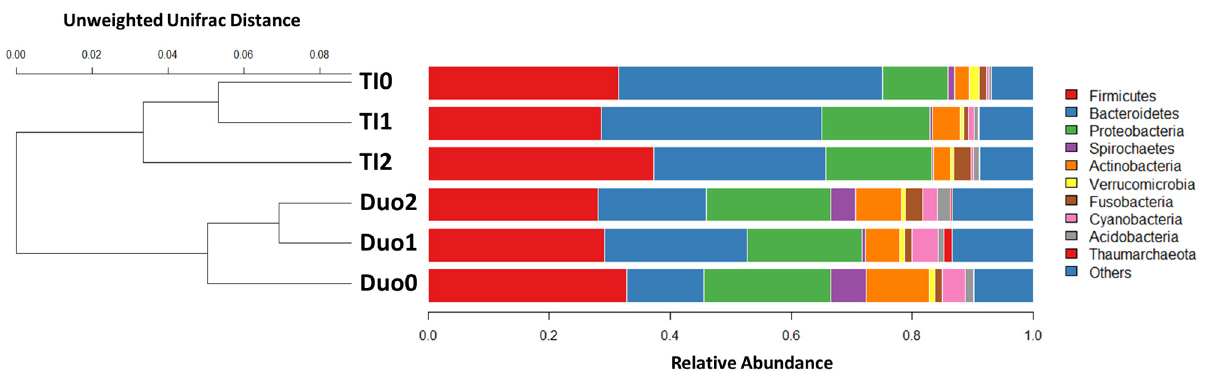
Figure 2. Unweighted Pair-group Method with Arithmetic Mean (UPGMA) analysis to assess and compare alpha and beta diversity across tissues and study groups. The bar chart depicts the relative abundance of bacteria at the phyla level for both the duodenum (Duo) and terminal ileum (TI). The dendrogram on the left allows comparison across tissues and study groups, highlighting the largest degree of difference between Duo and TI, Duo0 & TI0-Controls, Duo1 & TI1-Active CD at that biopsy site, and Duo2 & TI2-CD without active inflammation at that biopsy site, but present elsewhere. To further explore whether concomitant medication use could explain some of the differences in OTU abundance observed in the duodena of children with CD vs.